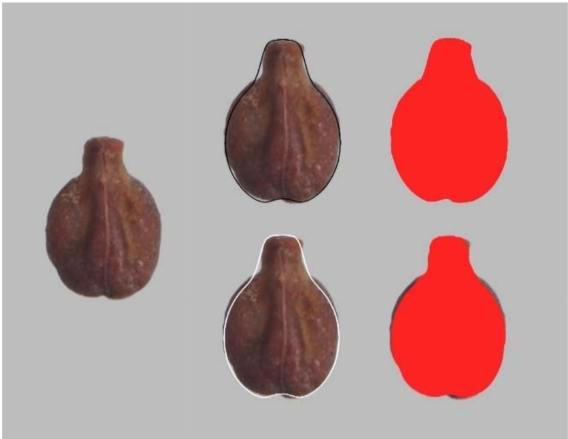
Figure 2. Schematic representation of the method used to obtain J index. J index is the ratio between shared and total area in two images. Left: a seed from the cultivar Albillo Real. Middle: The same seed with the model superimposed; above, with the model in black; and below, the model in white. Right: Red zones show the areas quantified in each of the figures. ImageJ gives the total area for the seed with the model in black, while shared area is obtained with the white